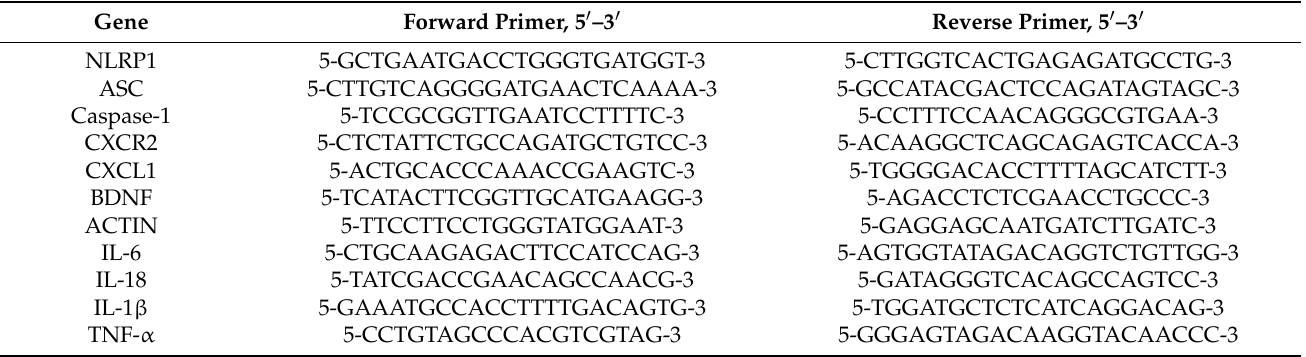
Table 1. The PCR primer